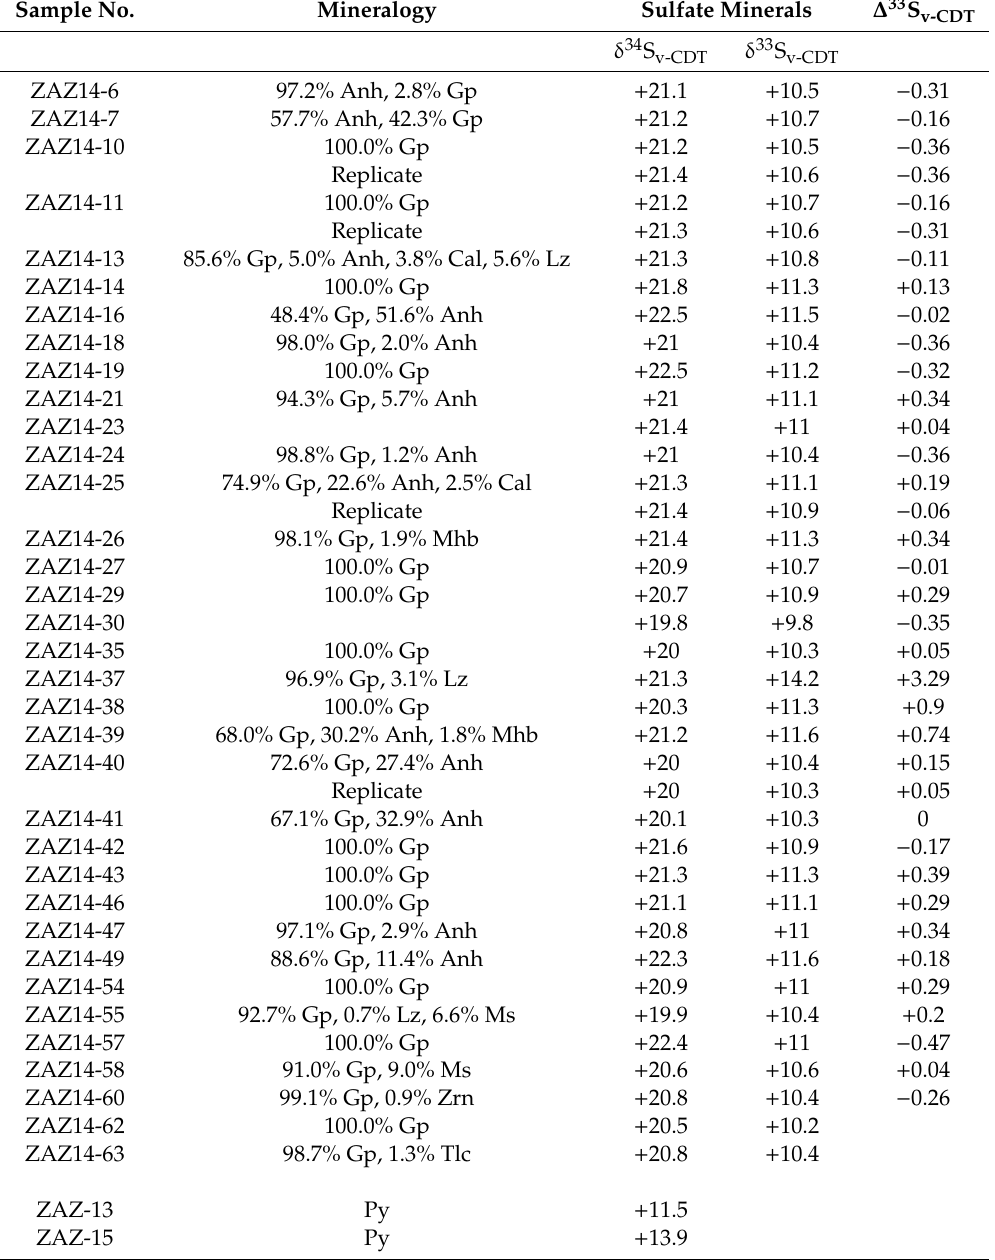
Table 1. S isotopic compositions (% (cid:24) ) of anhydrite and gypsum from the Zhaoanzhuang iron deposit. (Abbreviations: Anh, anhydrite; Gp, gypsum; Lz, lizardite; Cal, calcite; Mhb, magnesiohornblende; Ms, muscovite; Zrn, zircon; Tlc, talc; and Py, pyrite). Sample